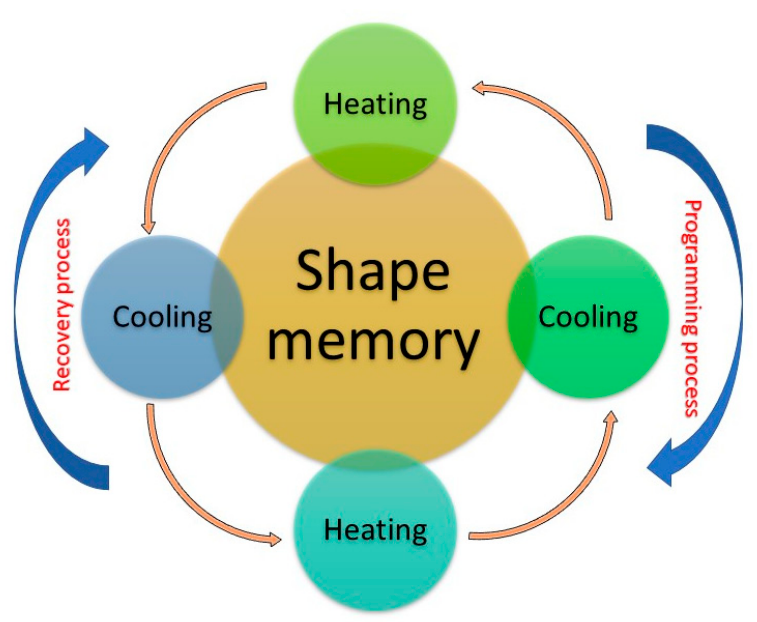
Figure 4. Representative scheme of SMP cycle. The material can be deformed when cold but returns to its pre-deformed (“remembered”) shape when heated.